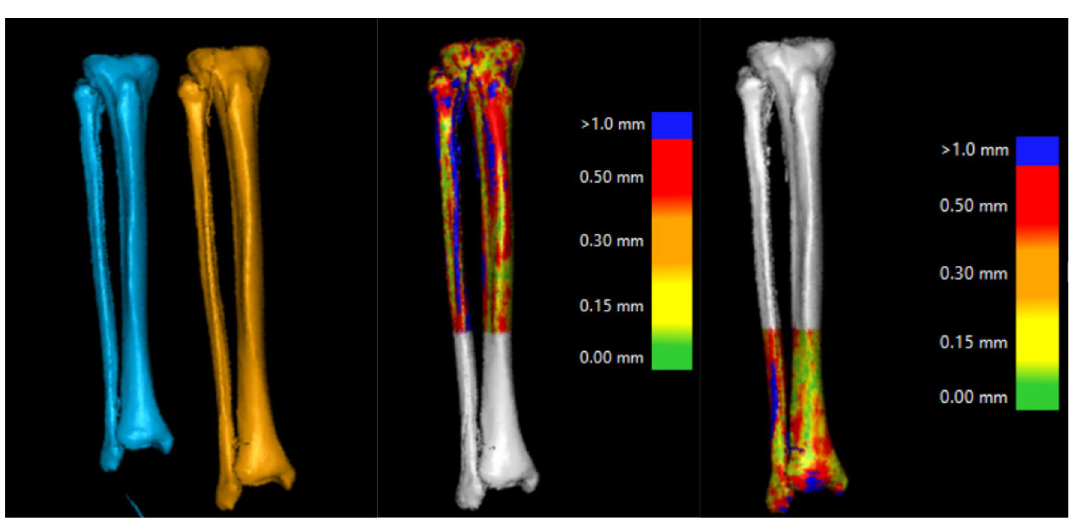
Figure 2. Illustrates merging of mirrored images of the left lower leg and the right lower leg. Initially the proximal parts are merged and assumes as static. Further, the distal parts are merged and assumed as